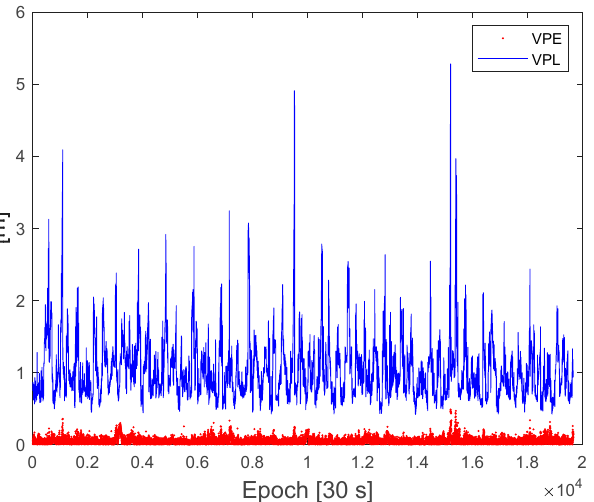
Figure 9. Comparison of the vertical protection levels and vertical position errors from the test dataset.